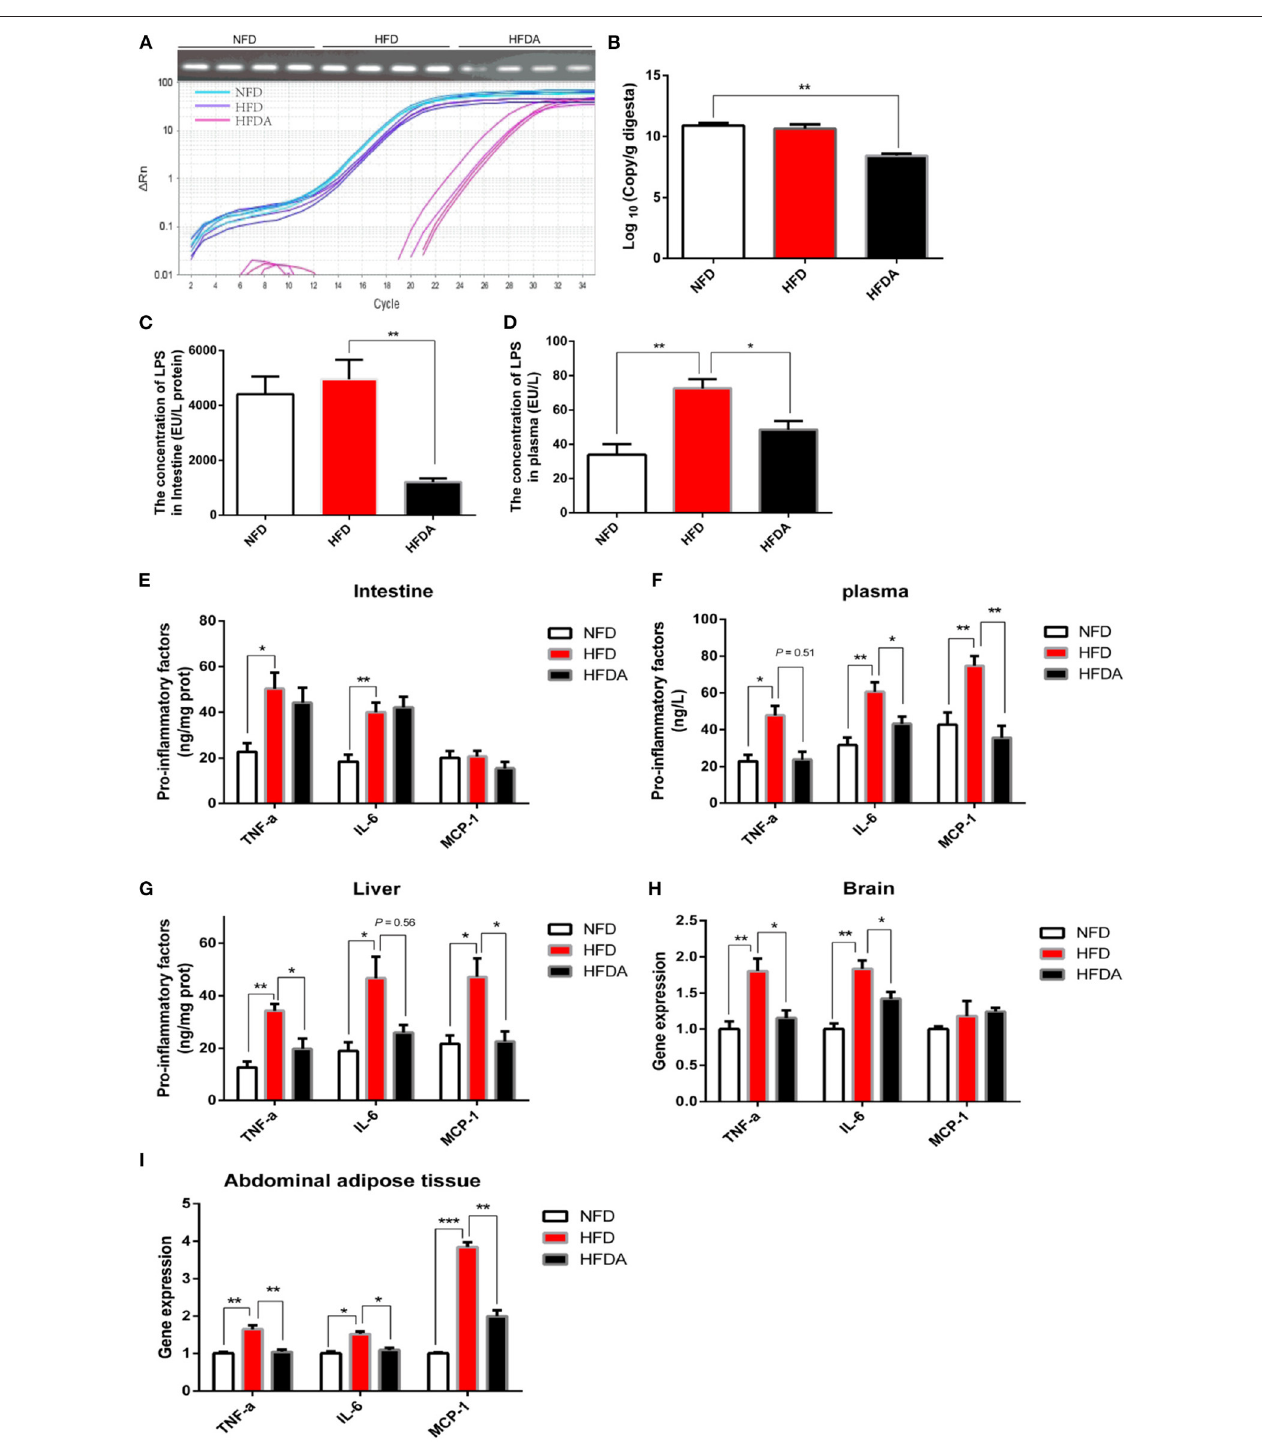
FIGURE 2 | Antibiotic interference inhibits the penetration of LPS and then alleviates chronic inflammation induced by high fat. Fish were fed a normal-fat diet (5% fat, NFD), a high-fat diet (10% fat, HFD) or a high-fat diet supplemented with antibiotic (vancomycin 2 g/kg, erythromycin 4 g/kg, neomycin sulfate 4 g/kg and metronidazole 4 g/kg, HFDA) for 12 weeks. (A) Abundance analysis of total bacteria: agarose gel electrophoresis and PCR amplification curve. (B) Quantitative analysis of total bacteria. (C,D) The content of LPS in intestine (C) and plasma (D) . (E–G) The protein content of pro-inflammatory factors (TNF- α , IL-6 and MCP-1) in the intestine (E) , plasma (F) and liver (G) . (H,I) Gene expression of pro-inflammatory factors in brain (H) and abdominal fat tissue (I) . Data are shown as mean ± SEM. N = 4. Two-tailed unpaired Student’s t -test was used. * P < 0.05, ** P < 0.01, *** P <